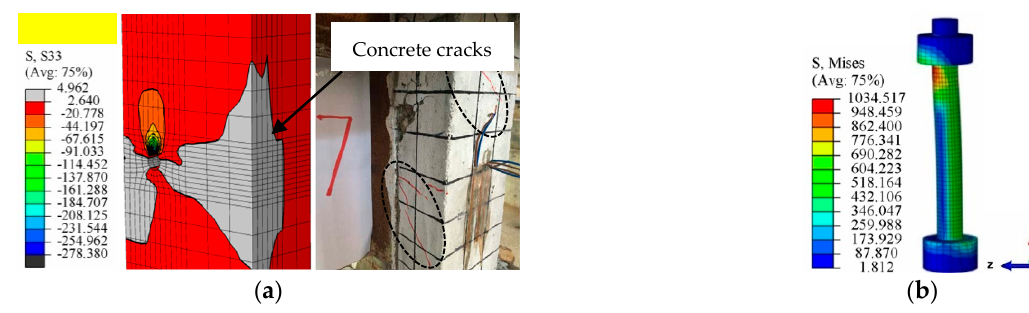
Figure 8. Failure model of the T2-1 specimen under inverse push-off loading: ( a ) concrete; ( b ) bolt.